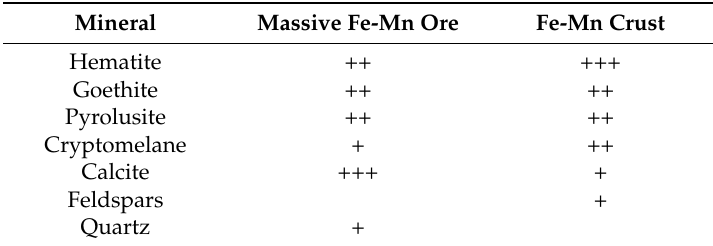
Table 1. Representative XRD analyses of Fe-Mn mineralized samples from the the Legrena valley, Lavrion (+: relative abundance of